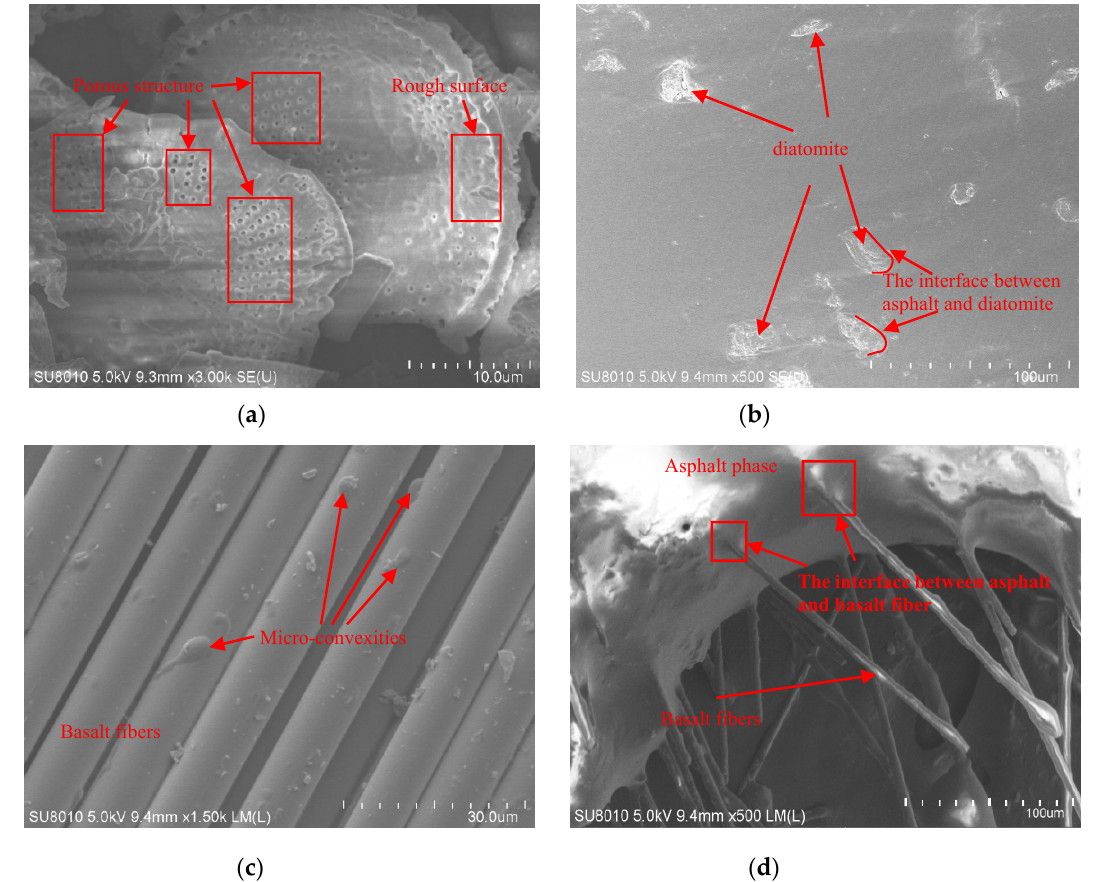
Figure 3. SEM micrographs: ( a ) Diatomite (D); ( b ) diatomite in asphalt; ( c ) basalt fiber (B); ( d ) basalt fibers in asphalt.